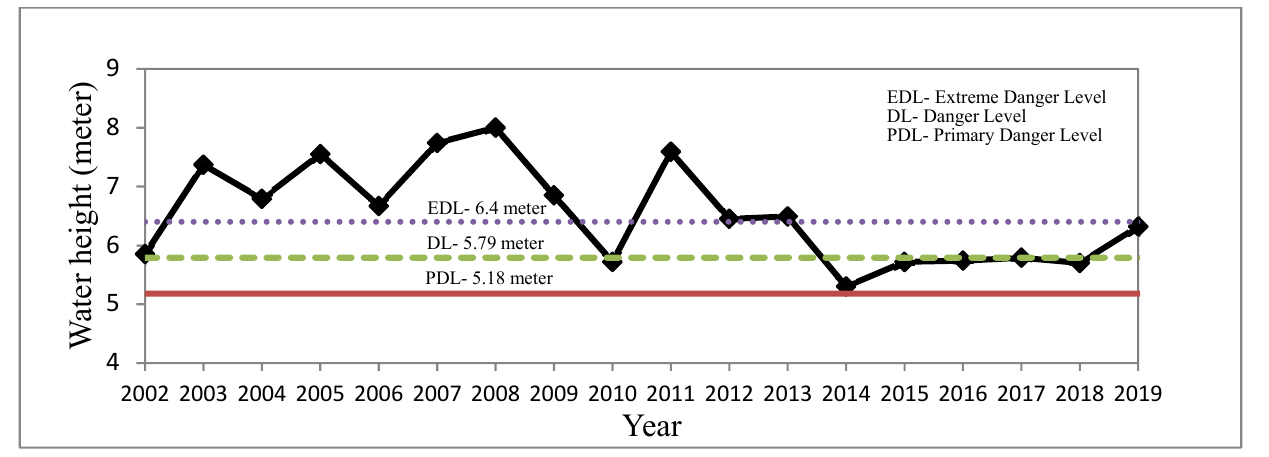
Figure 7. Highest gauge height in Kaliaghai river at Amgachia rain gauge station (2002–2019). During the study period, the Tamluk, Kolaghat, Nandakumar, Patashpur-II, Bhagawanpur-I, Egra-I, and Ramnagar-I blocks suffered ten to eleven floods that